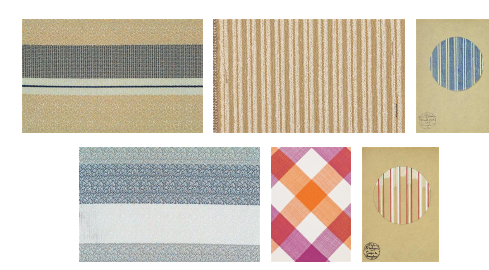
Figure 4. Exemplary result for k-NN analysis. The top left image is the query image, the other images are the five nearest neighbours. All properties of the query image were predicted correctly. Classes for all images: Catalonia, 2 nd 19 th , jacquard . photographer: Quico Ortega.